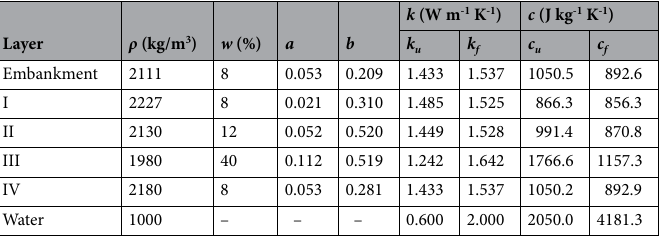
Table 1. Thermal parameters of the soils in the Beiluhe Permafrost Station. Data can be referred from paper 10 ; physical meanings of some parameters are referred to the Appendix A of Supplementary